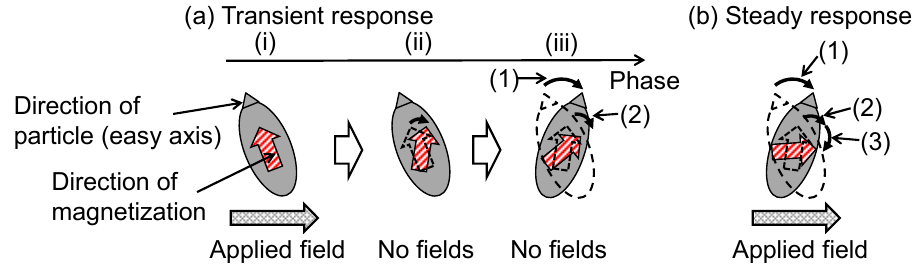
Figure 6. Schematic of the magnetic nanoparticle (MNP) magnetization and particle rotations in the ( a ) transient and ( b ) steady ‐ state responses, under conditions where the Néel relaxation is faster than the Brownian relaxation. In the transient response, ( a ‐ i ) a magnetic field is applied and the Zeeman energy is increased; ( a ‐ ii ) The magnetization rotates owing to the increase of the Zeeman energy in phase ( a ‐ i ); ( a ‐ iii ‐ 1 ) The particle rotates owing to the magnetic torque caused by the magnetization rotation in phase ( a ‐ ii ); and ( a ‐ iii ‐ 2 ) the magnetization rotates owing to the decrease of the anisotropic energy caused by particle rotation; In the steady ‐ state response, ( b ‐ 1 ) particle rotation due to magnetic torque, ( b ‐ 2 ) magnetization rotation due to the decrease of the anisotropic energy; and ( b ‐ 3 ) magnetization rotation caused by the increase of the Zeeman energy occur.